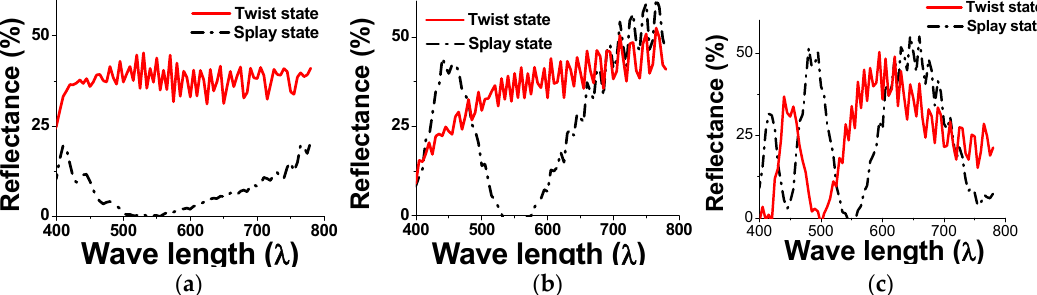
Figure 9. Measured reflectance of both splay and twist states of BCSN device with retardations of ( a ) 137.5 nm, ( b ) 412.5 nm, and ( c ) 687.5 nm.